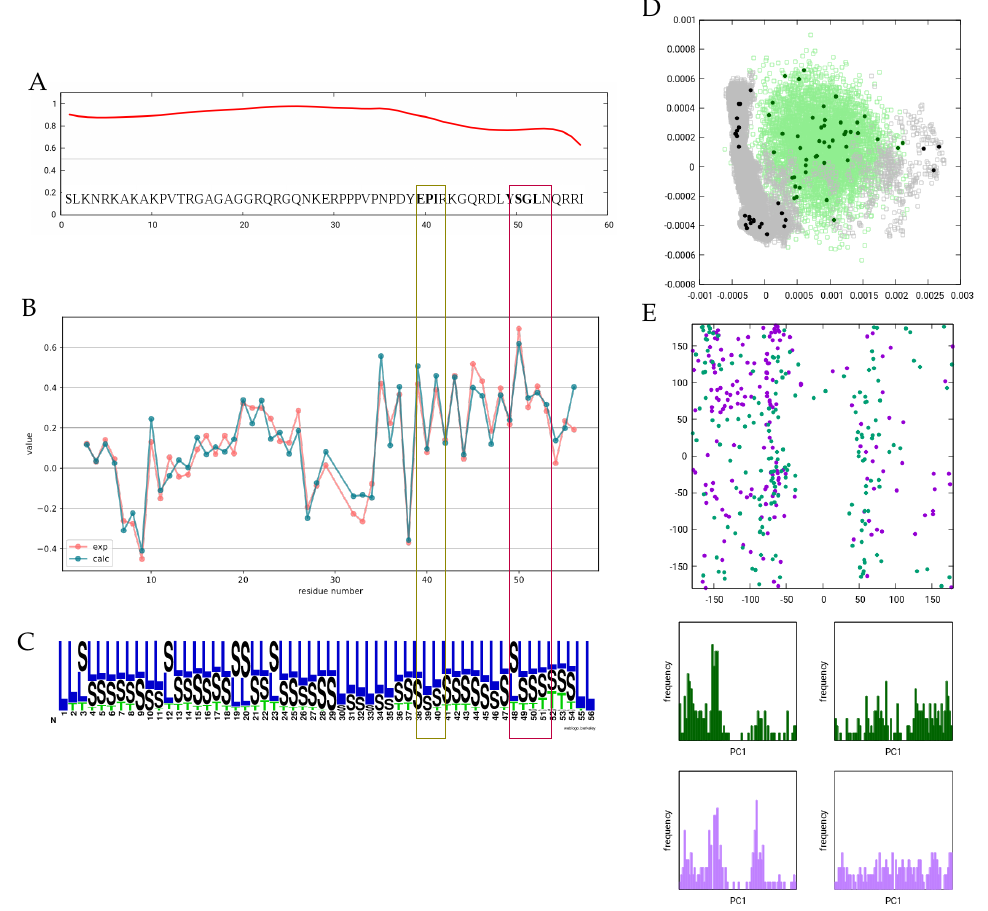
Figure 2. Overview of the Cd3 (cid:101) ensemble. ( A ) Disorder propensity as predicted by the IUPred3 server. ( B ) Observed and calculated CA secondary chemical shifts. ( C ) Secondary structure logo for the ensemble selected based on CA chemical shifts. DSSPcont states are averaged for all models. Figure prepared with Weblogo. ( D ) PCA of the simulated, generated and selected (sub)ensembles. ( E ) Ramachandran plot of all residues in the ITAM1 (dark-green) and ITAM2 (purple) motifs in all structures of the selected